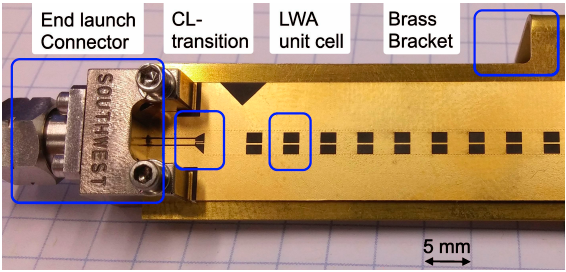
Figure 3. Schematic diagram of the antenna measurement setup.